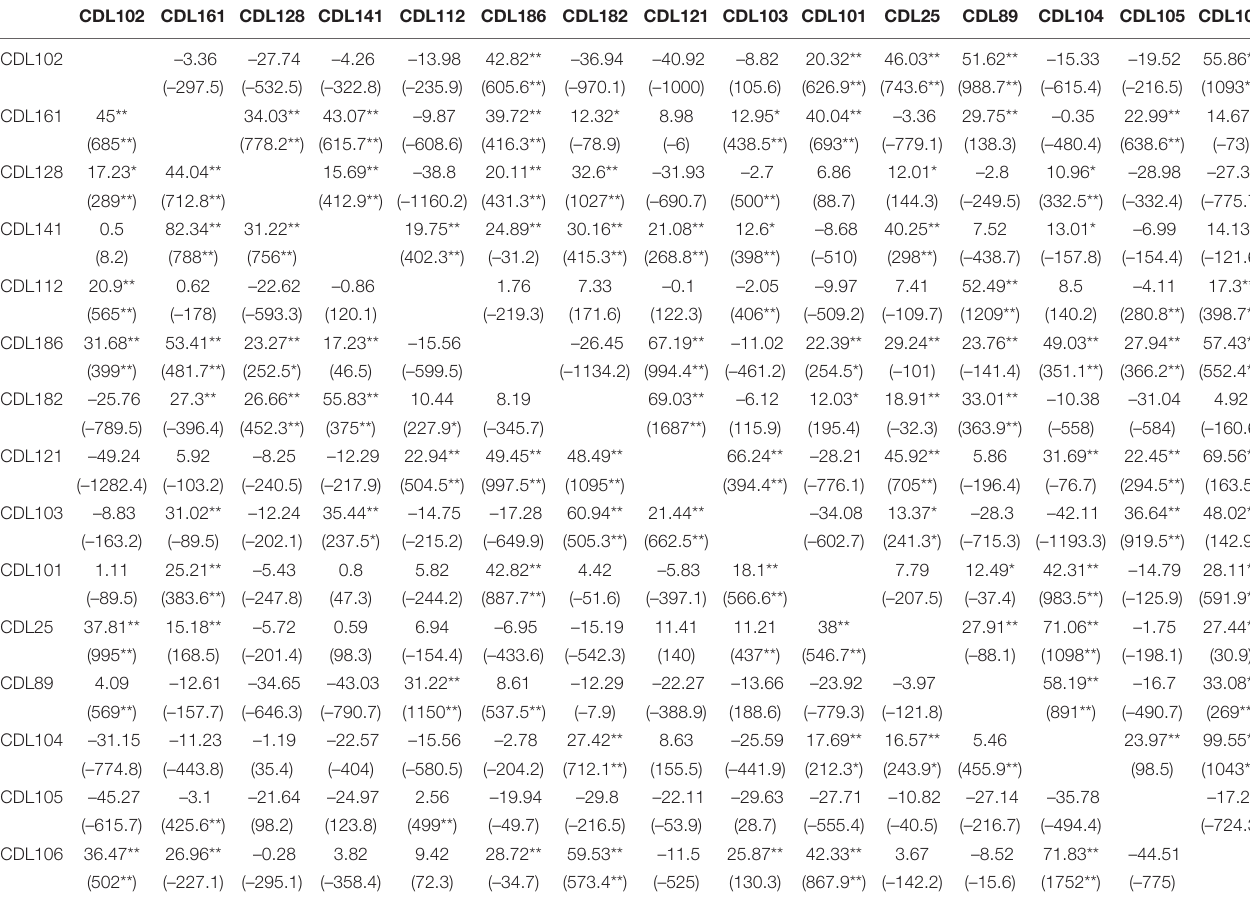
TABLE 5 | Estimates of heterobeltiosis and specific combining ability (SCA) effects of 105 hybrids of CDLs for seed yield (kg/ha) under irrigated and rainfed